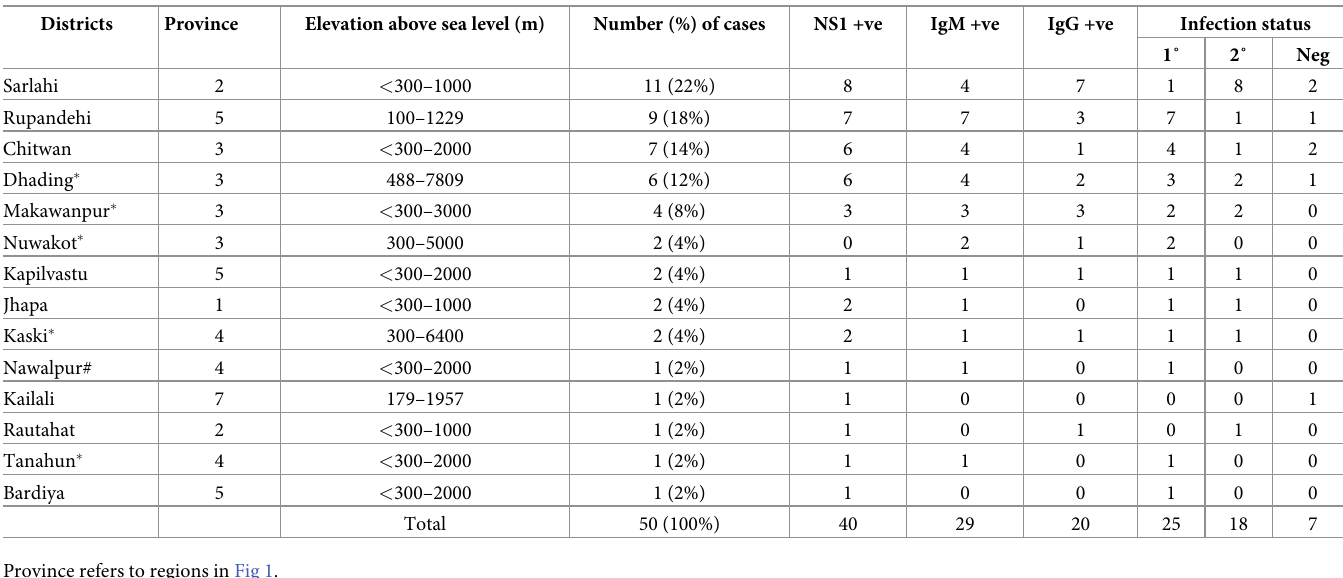
Table 4. Distribution and infection status of patients with suspected dengue